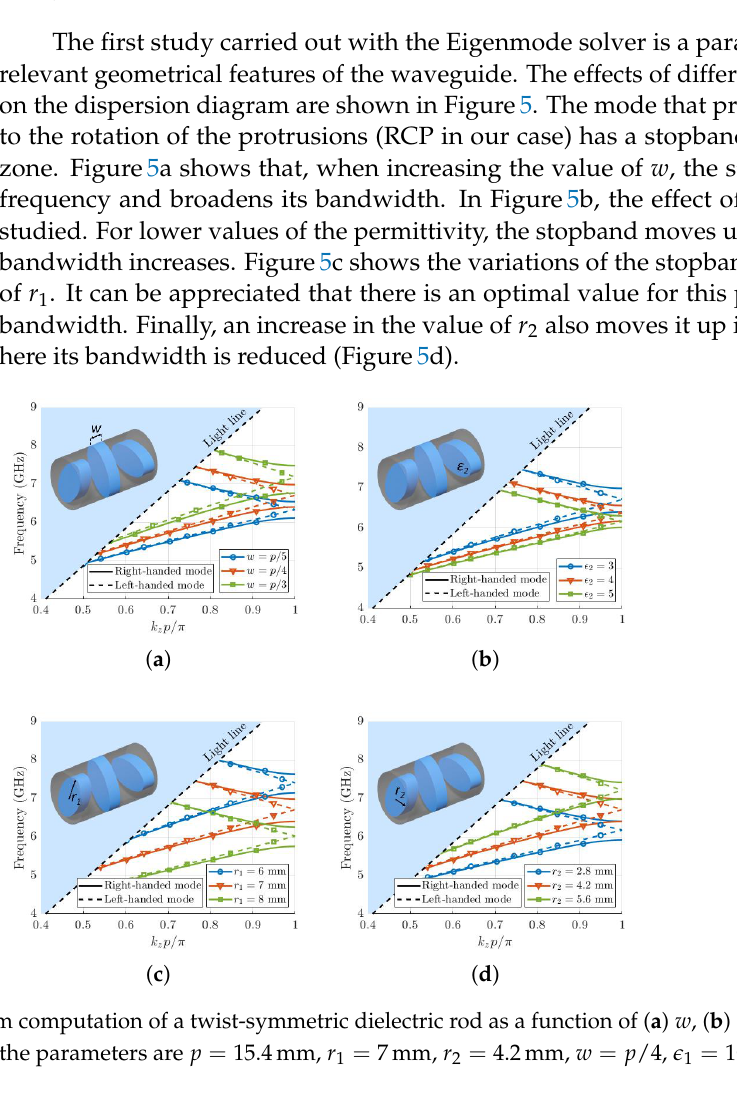
Figure 4. Field distribution showing the rotation of the circularly polarized HE 11 modes computed by the Eigenmode solver at 7.2GHz for p = 15.4mm, w = p /4, r 1 = 7mm, r 2 = 4.2mm, (cid:101) 1 = 10 and (cid:101) 2 = 3.